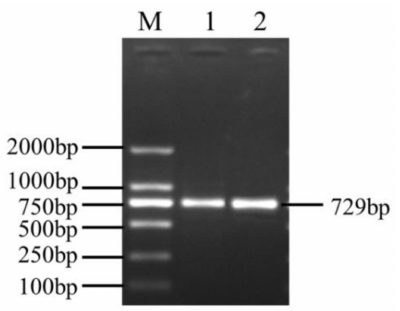
Figure 1. PCR amplification products of the Tibetan sheep GLOD4 coding sequence (CDS) sequence. M, DL 2 000 marker; 1 and 2, PCR